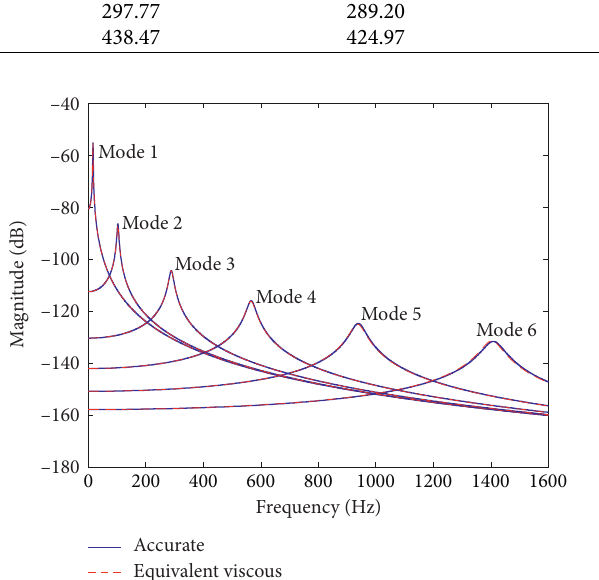
Figure 7: Comparison of the modal FRFs for the first six modes.